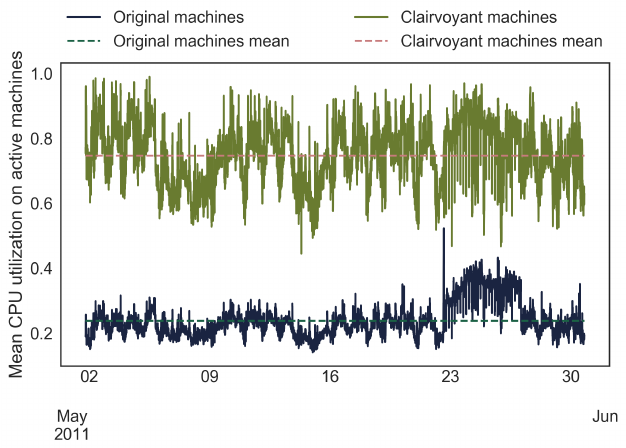
Figure 3. Mean CPU utilization on the currently active machines during the month-long trace period. Overall mean for the original machines: 0.24, overall mean of clairvoyant machines: